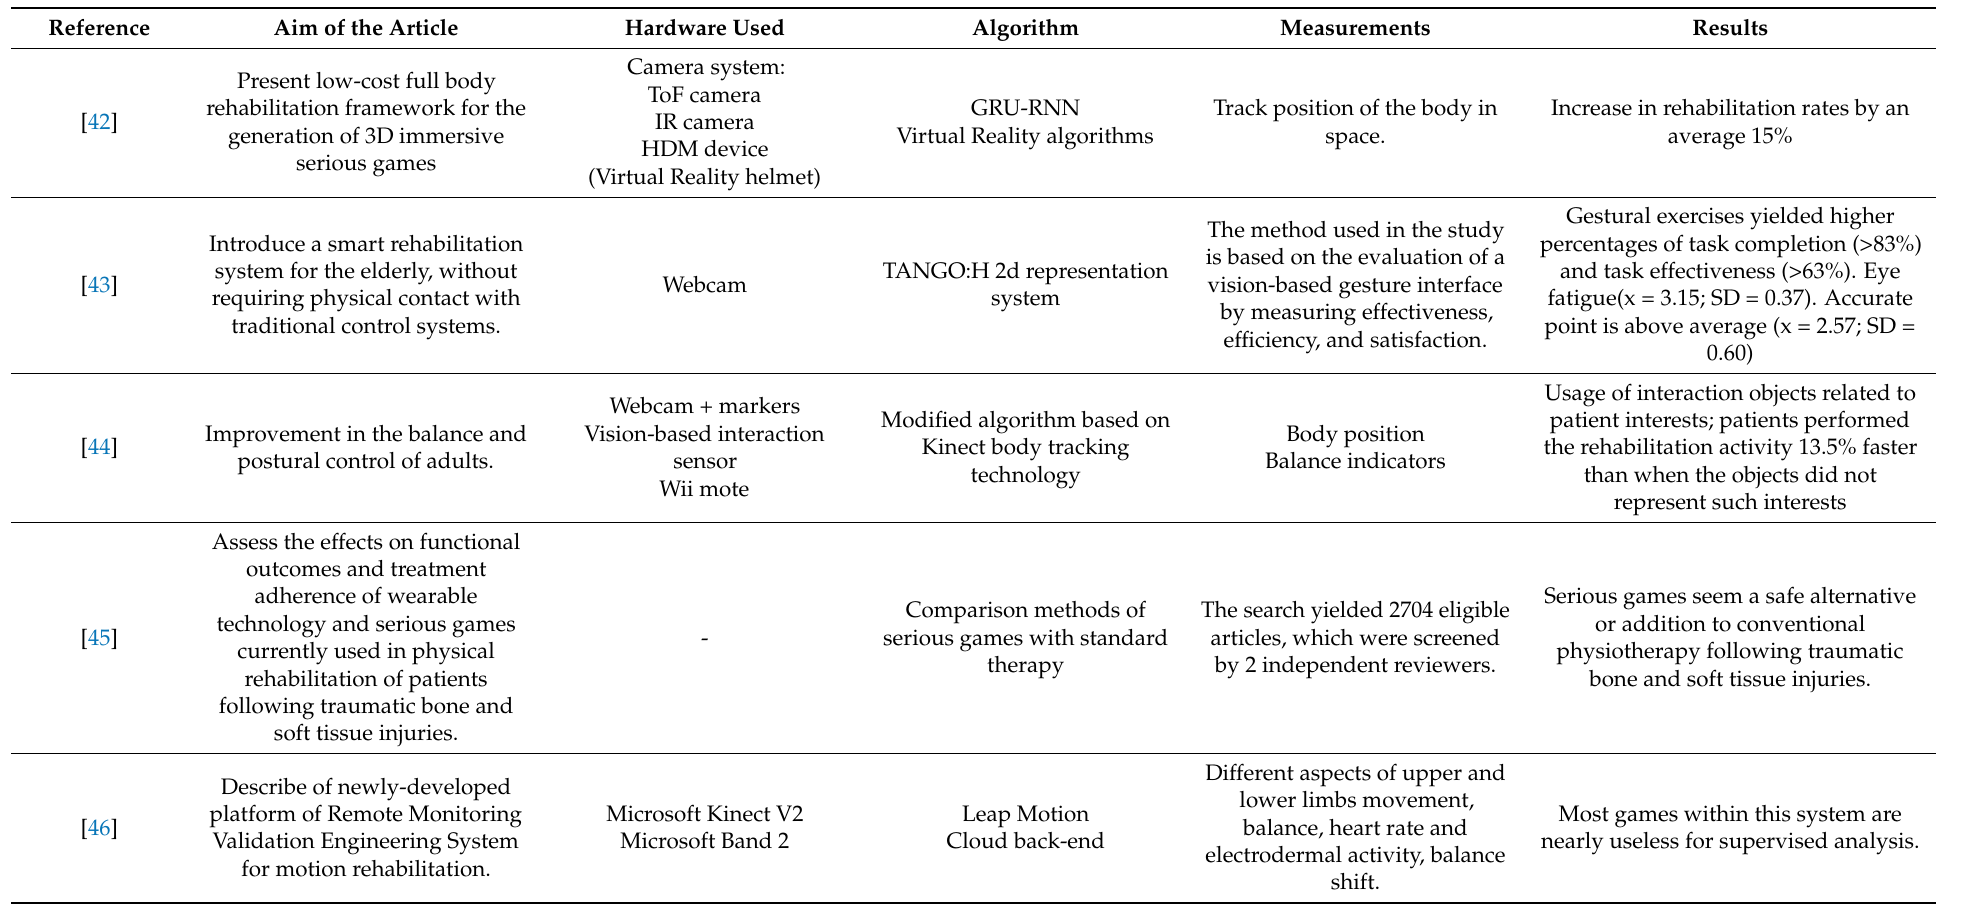
Table 1. Comparison between similar